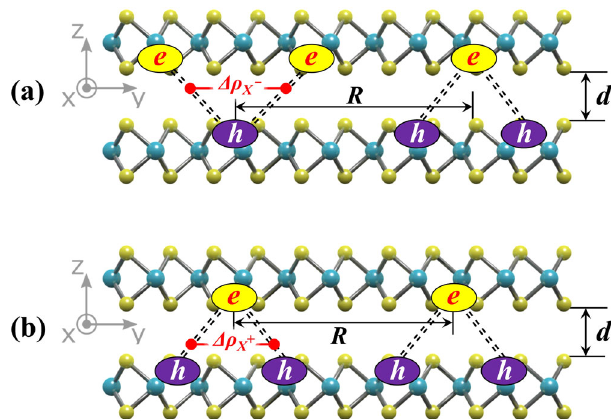
Fig. 1 Charged interlayer exciton structure and interaction geometry. The compound structure and the symmetry-promoted most likely pairwise interaction geometry for the unlike-charge ( a ) and like-charge ( b ) interlayer exciton (IE) complexes in a bilayer quasi-2D semiconductor of the interlayer separation d . Here, Δ ρ X (cid:2) and Δ ρ X þ indicate the center-of-mass- to-center-of-mass distances for the two IEs sharing the same hole or the same electron, respectively, to form the respective charged interlayer excitons (CIEs, or interlayer trions), and R shows the center-of-mass-to- center-of-mass distance for the two CIEs in the